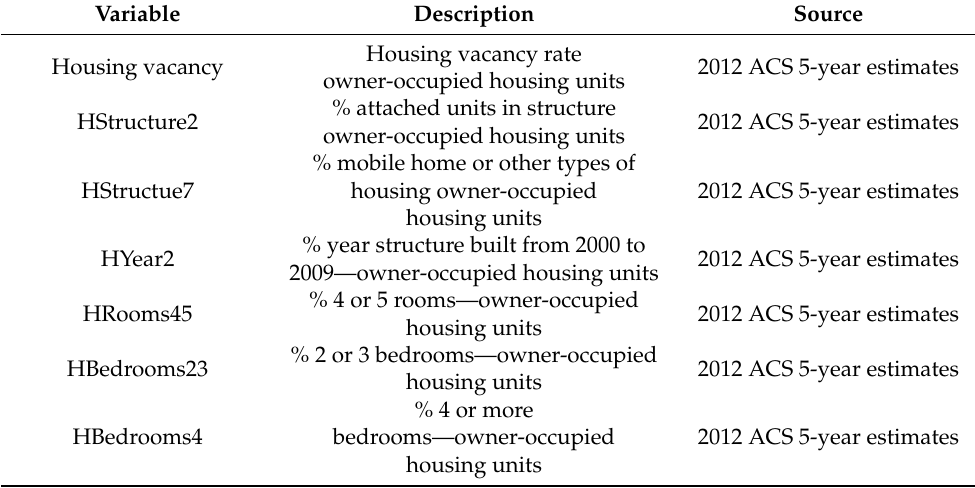
Table A10. Housing characteristics for rent equations and personal/household characteristics for wage